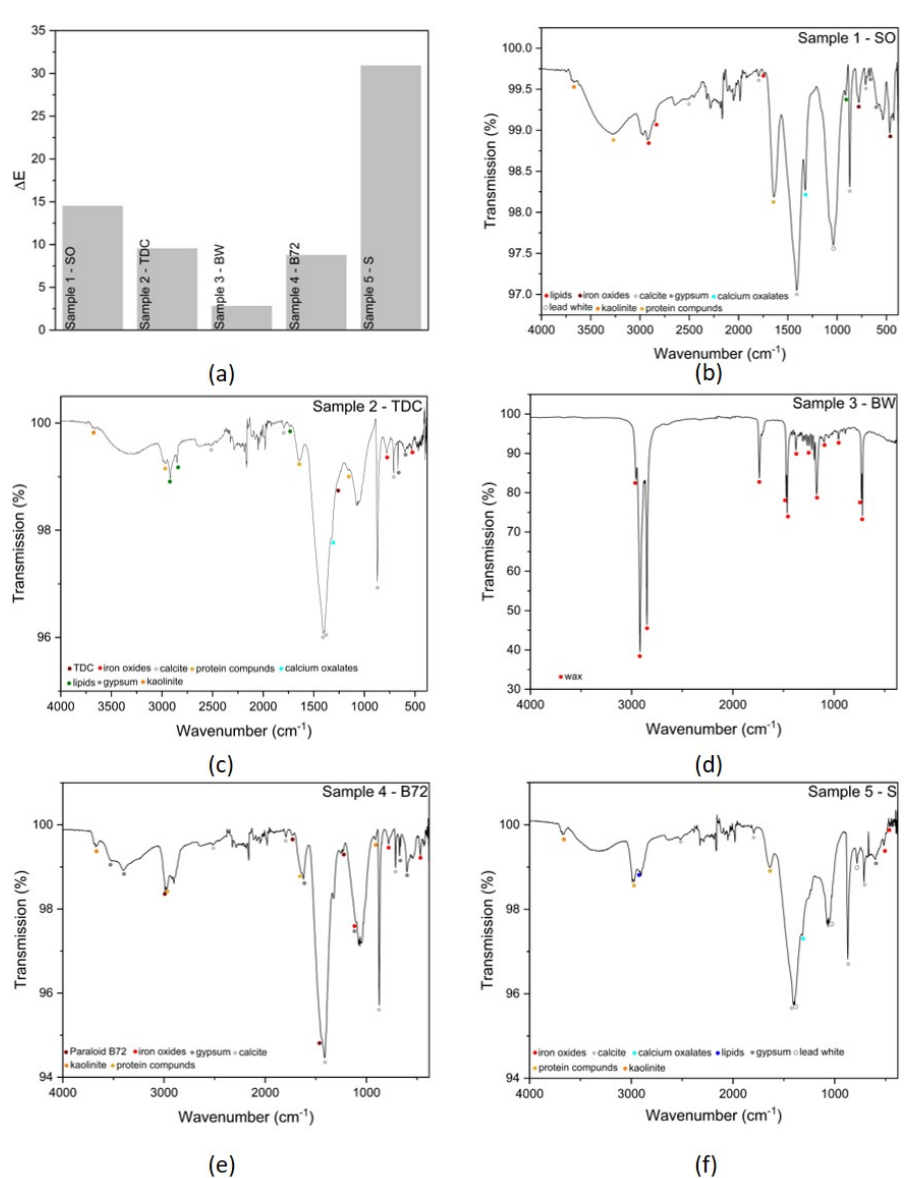
Figure 14. Colorimetry and FTIR spectroscopy performed on the fresco samples. ( a ) ∆ E values calculated from the colorimetric data; ( b ) FTIR spectrum of the sample with SO; ( c ) FTIR spectrum of the sample with TDC; ( d ) FTIR spectrum of the sample with BW; ( e ) FTIR spectrum of the samples with Paraloid B72; ( f ) FTIR spectrum of the sample with S.